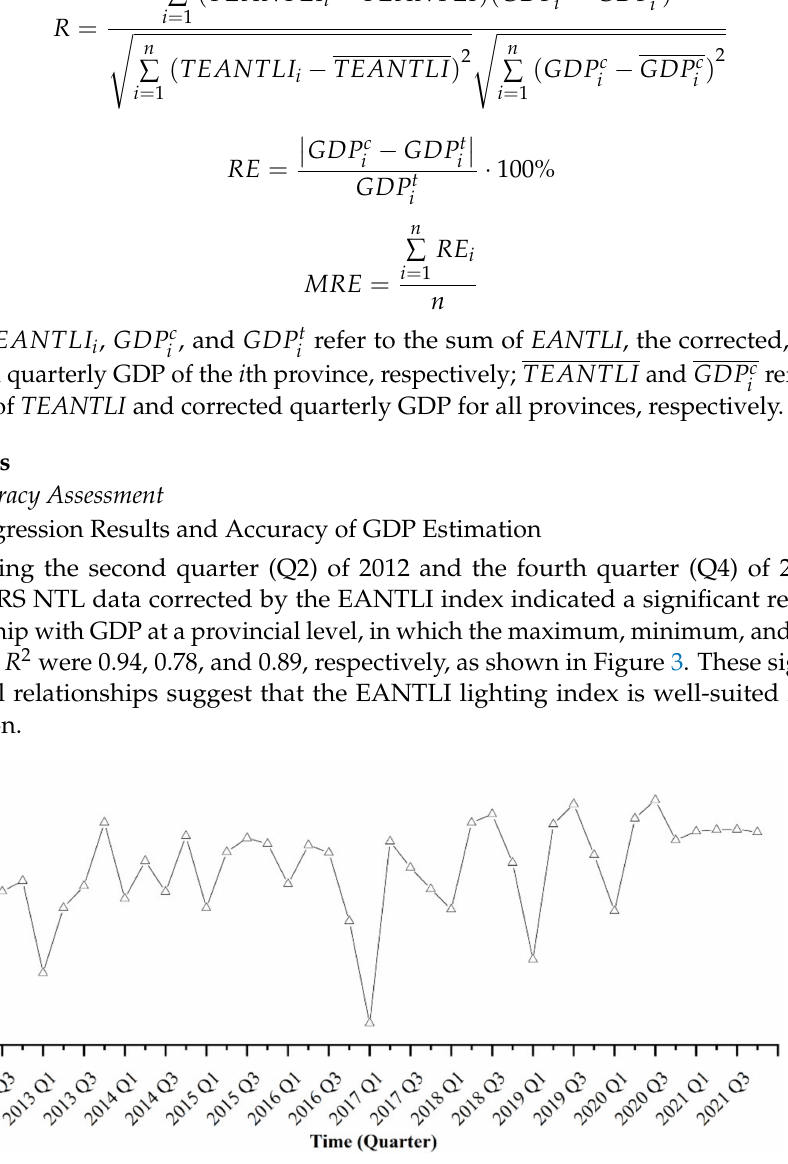
Figure 3. Coefficients of determination ( R 2 ) of the linear regression between the nighttime lighting index EANTLI and quarterly GDP for the 31 provinces from the 2nd quarter (Q2) of 2012 to the 4th quarter (Q4) of